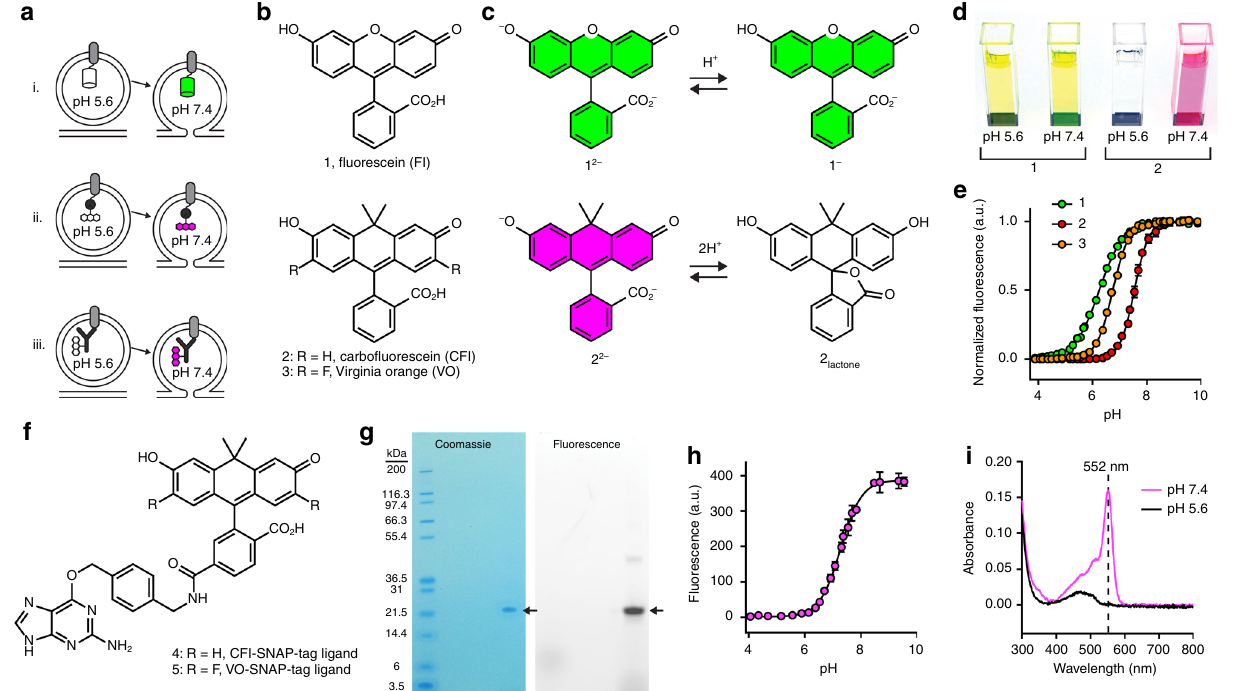
Fig. 1 Design and characterization of semisynthetic fl uorescent reporters for exocytosis. a Three protein labeling strategies for imaging exocytosis. Cartoons depicting vesicles expressing pH-sensitive fl uorescent protein, such as SEP or pHuji, fused to a SV protein (i) or SNAP-tag enzyme fused to an SV protein and labeled with a pH-sensitive organic fl uorophore (ii) and labeling of endogenous SV proteins with an antibody conjugated to a pH-sensitive dye (iii). b Chemical structures of Fl (1), CFl (2), and VO (3). c Fl and CFl respond differently to pH. Fluorescein undergoes noncooperative protonation from the dianion (1 2 − ) to the monoanion (1 − ), whereas carbo fl uorescein undergoes cooperative protonation from the highly colored dianion (2 2 − ) to a colorless lactone form (2lactone). d Image of cuvettes containing compounds 1 or 2 (5 μ M) at pH 5.6 and pH 7.4. e Plot of fl uorescence vs. pH for compounds 1, 2, and 3. f Chemical structure of CFl – SNAP-tag ligand (4) and VO – SNAP-tag ligand (5). g PAGE of SNAP-tag protein labeled with compound 4 and visualized by Coomassie staining or by fl uorescence (indicated by arrows). h Plot of fl uorescence vs. pH for 4 – SNAP-tag conjugate. p K a = 7.3 and η H = 1.2. i Absolute absorbance of 4 – SNAP-tag conjugate (~3 µ M) at pH 7.4 (magenta) and pH 5.6 (black). Error bars represent s.d. for 4 experiments